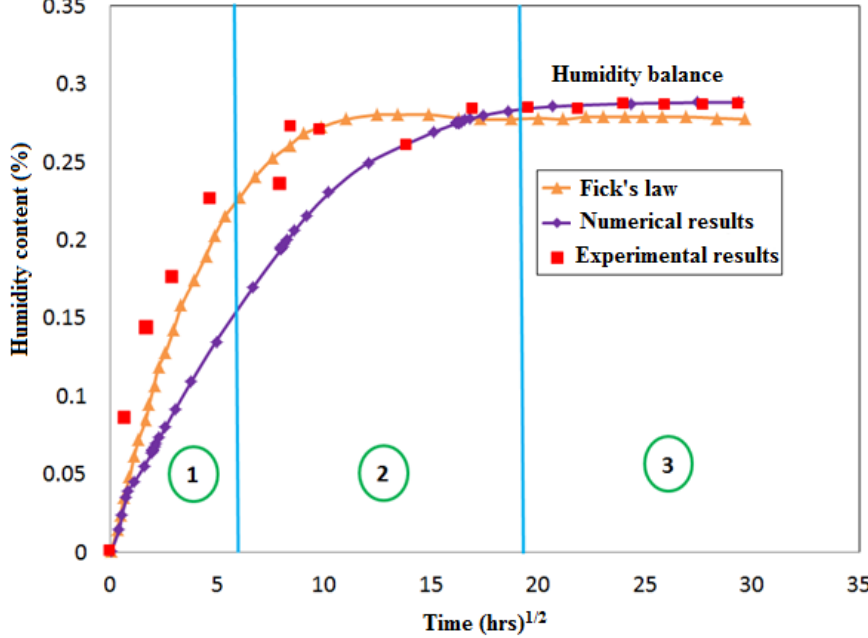
Figure 4. Bonded joint moisture absorption, a comparison of analytical (Fick) and numerical models with experimental data.